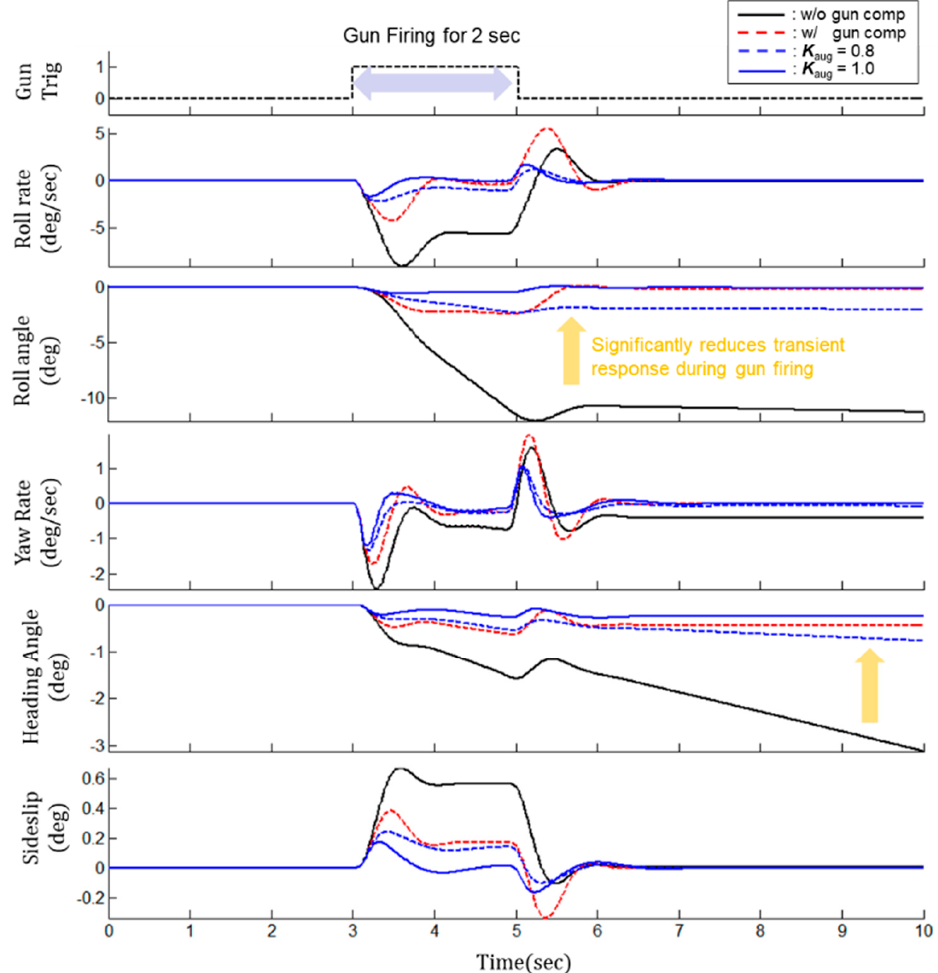
Figure 9. Result of lateral-direction transient response during gun firing for each control method at M0.8, 10 kft altitude, 1 g level fl ight.